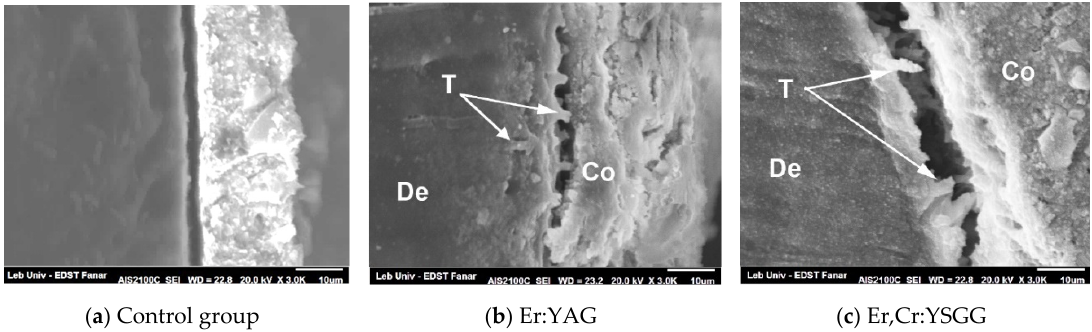
Figure 4. Longitudinal cut after thermocycling: ( a ) no tags were visible ( b ) and ( c ) visible tags with